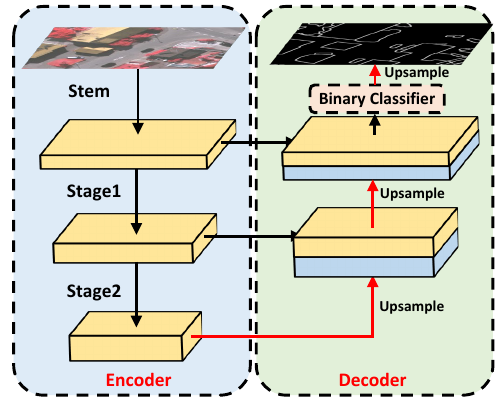
Figure 9. Architecture of the CNN-based edge extractor.